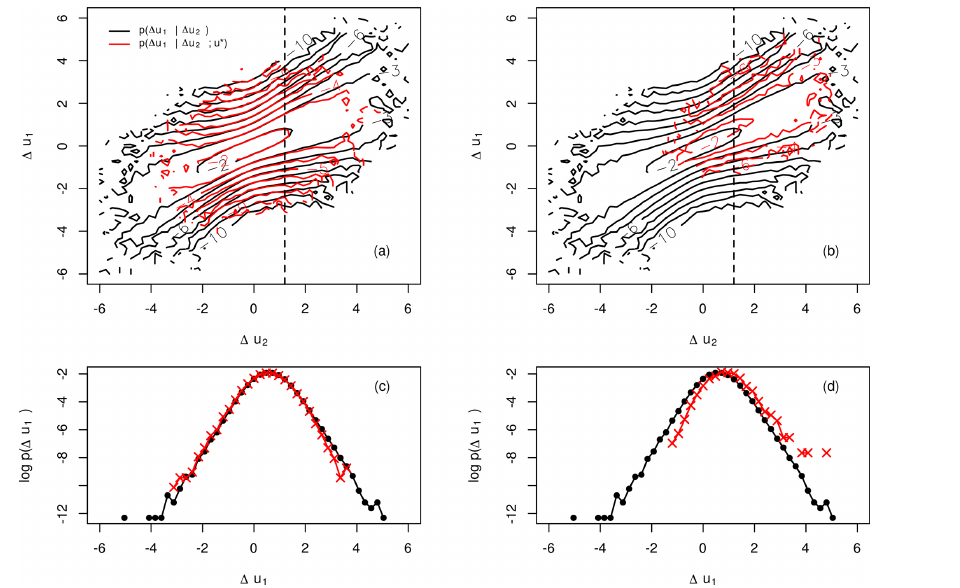
Figure 1. Comparison of single cpdf’s p ( (cid:49)u 1 | (cid:49)u 2 ) (black) and double cpdf’s p ( (cid:49)u 1 | (cid:49)u 2 ; u ∗ ) (red) for u ∗ ≈ 0 (a, c) , u ∗ ≈ 2 . 5 (b, d) , τ 1 = 1s and τ 2 = 2 τ 1 . Dashed lines indicate cuts through the cpdf’s at (cid:49)u 2 ≈ 1 . 2. The levels of the contour plots are given in natural logarithmic scale.